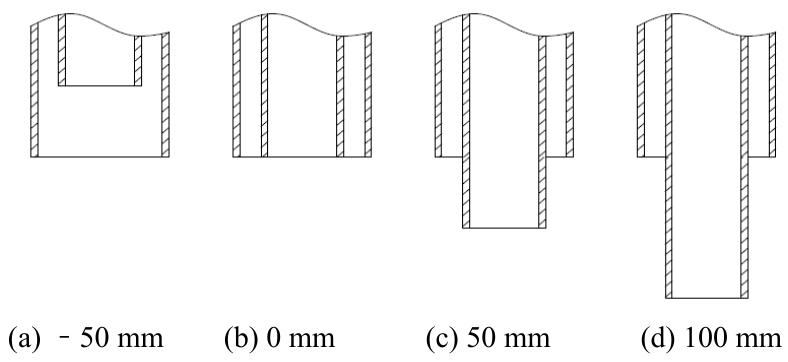
Figure 13. Insertion depth of inner vortex.